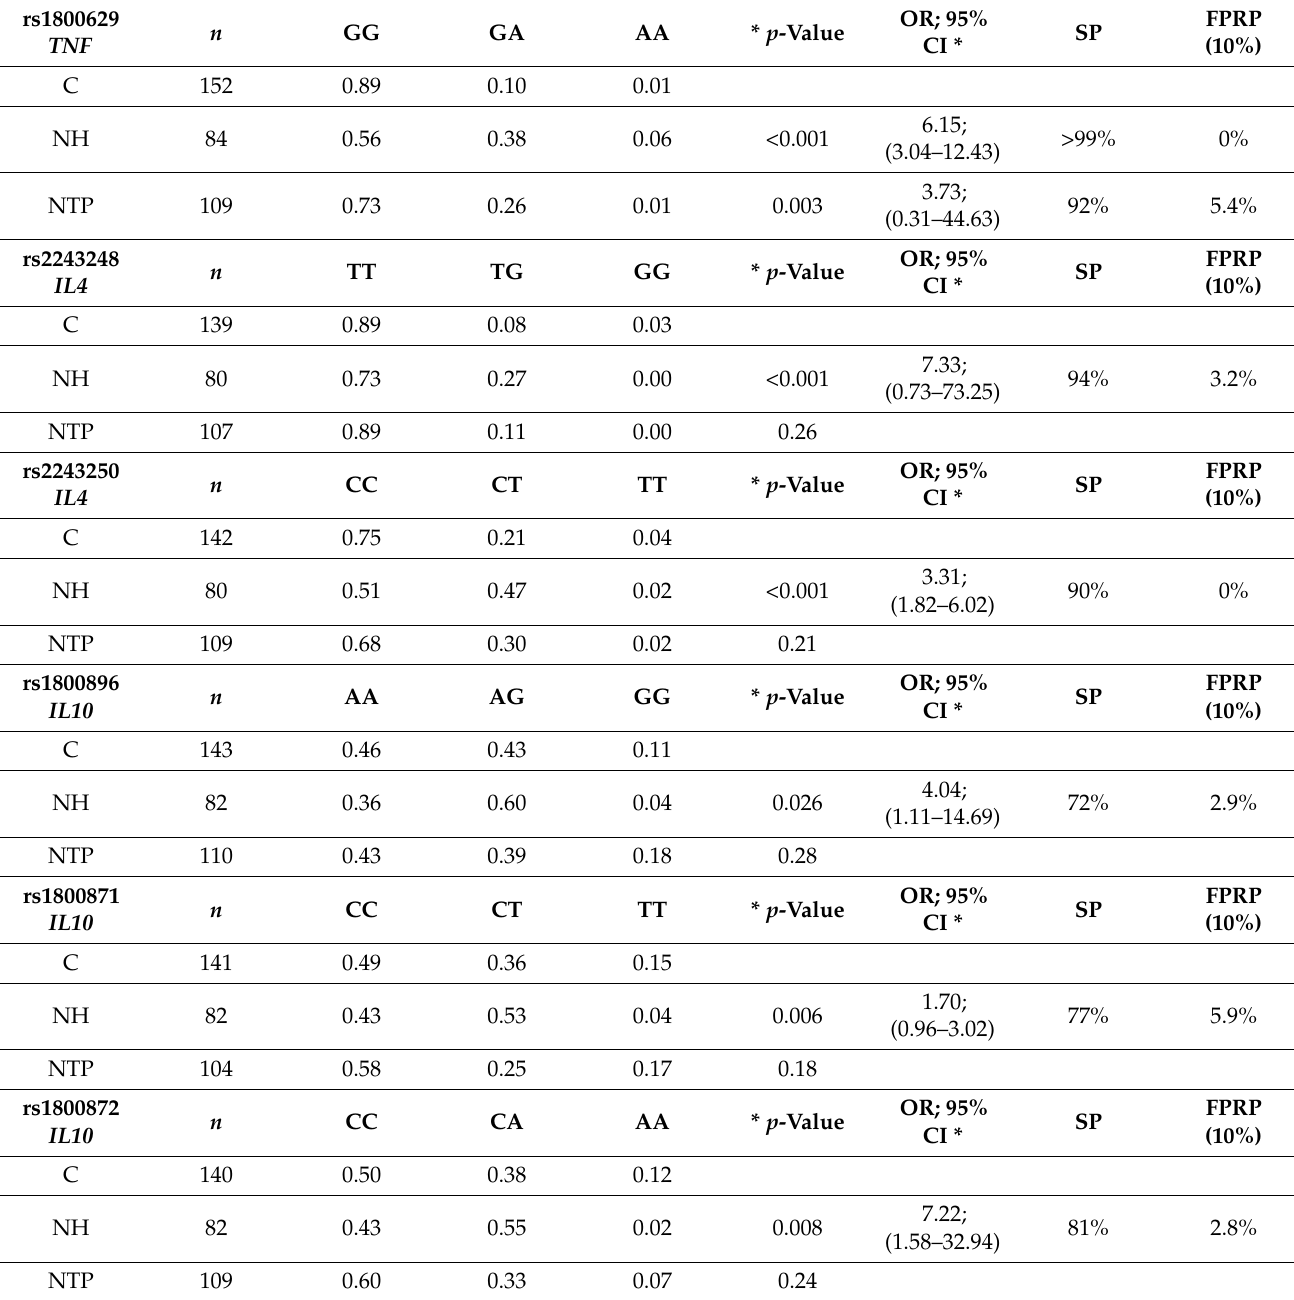
Table 4. Genotypic frequency distributions of the SNPs showed a significant association in NSAID hypersensitivity and NSAID-tolerant patients compared with